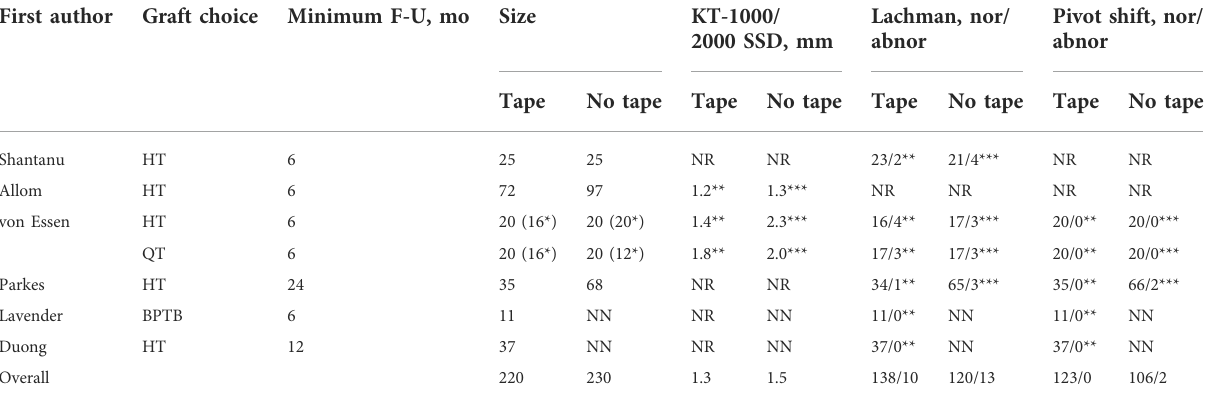
TABLE 6 Postoperative objective knee laxity between anterior cruciate ligament reconstruction with or without suture tape augmentation.